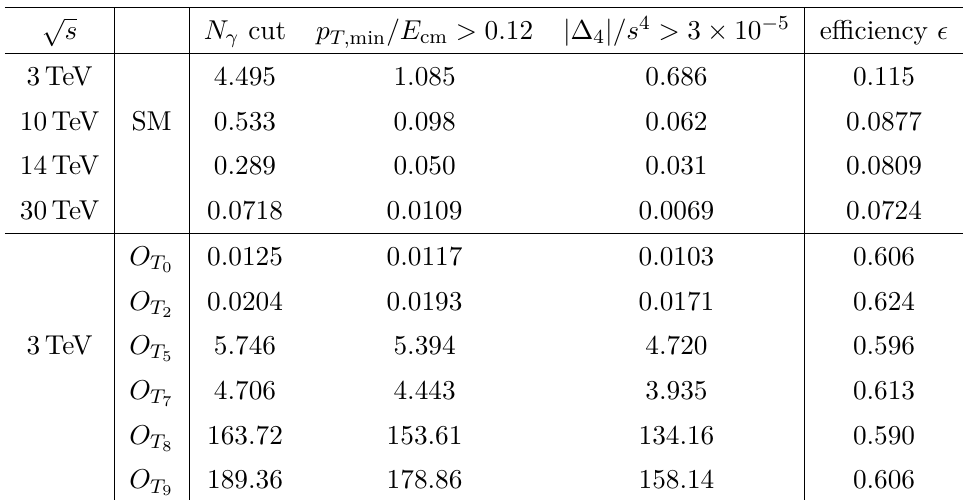
Table 3 . The cross-sections σ SM and σ O (in unit of fb ) and cut efficiencies after selection strategy. Ti The results of aQGCs are obtained using the upper bound of the coefficients in table 1.